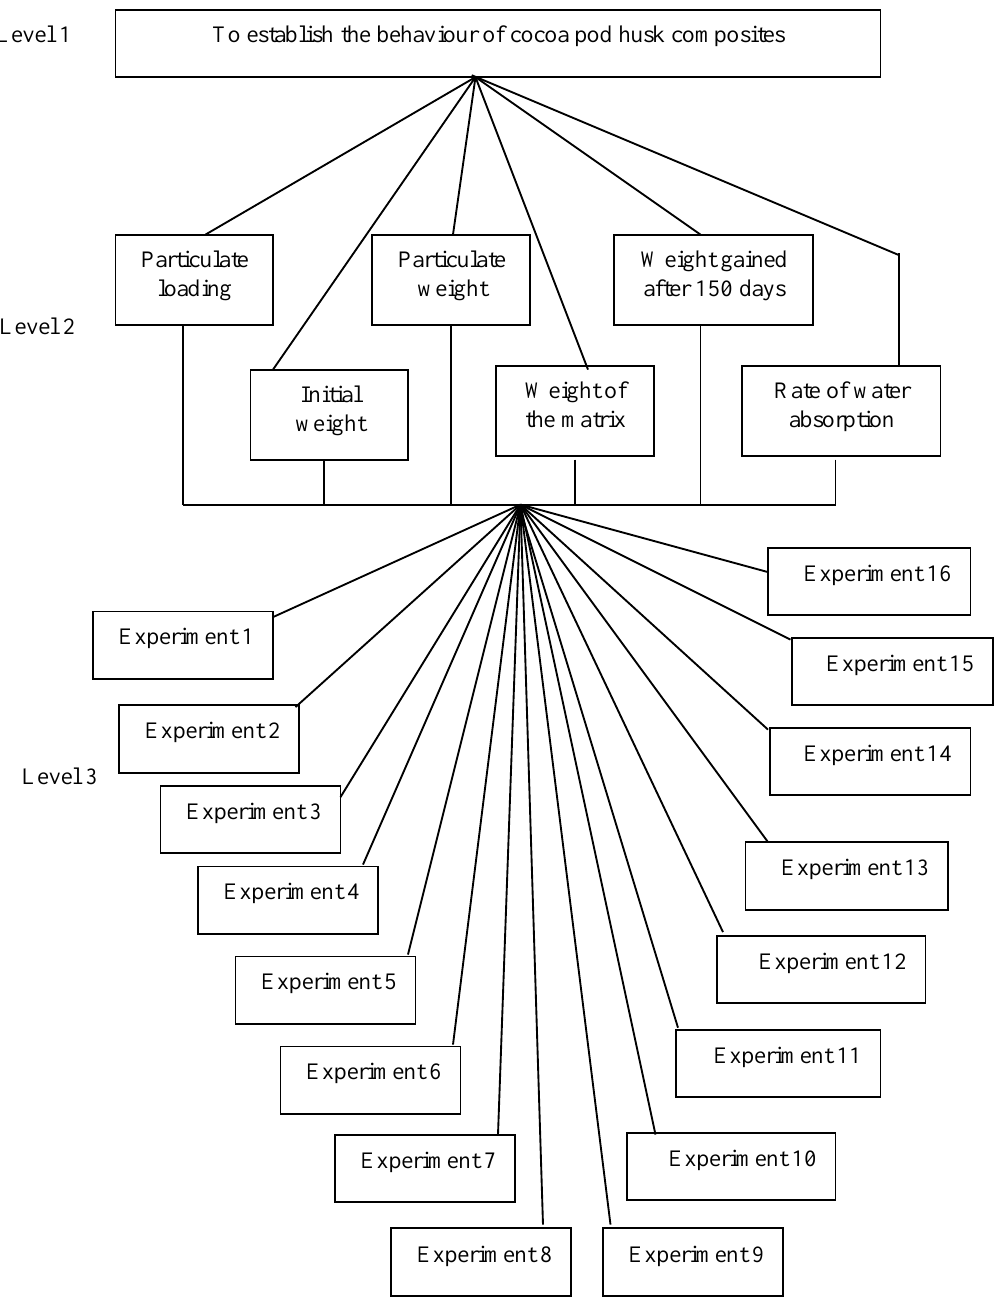
Fig. 1. AHP hierarchical structure for water absorption parameters of cocoa pod husk